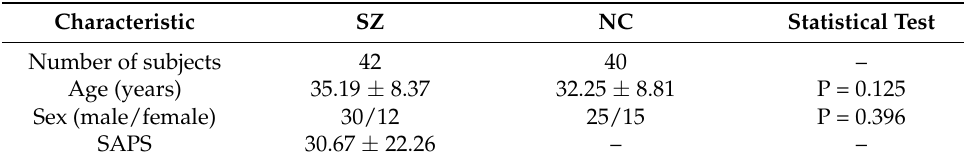
Table 1. Demographic and clinical characteristics.